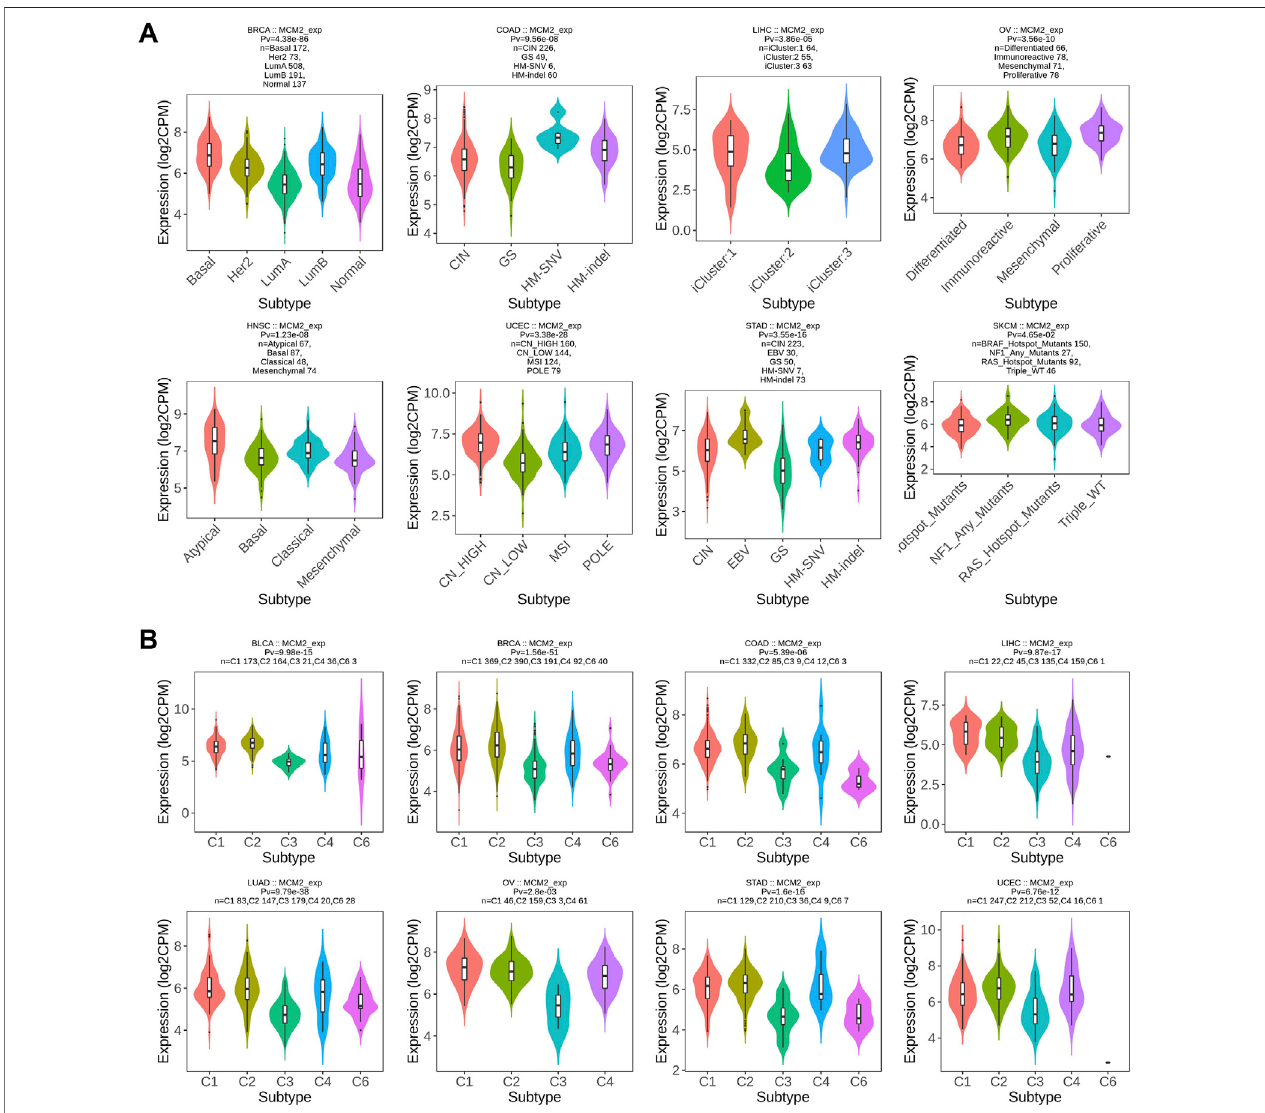
FIGURE 4 | Correlations between MCM2 expression and (A) molecular subtypes and (B) immune subtypes across TCGA cancers. CIN, chromosomal instability; GS, genomically stable; POLE, Polymerase ε ; EBV, Epstein-Barr virus.